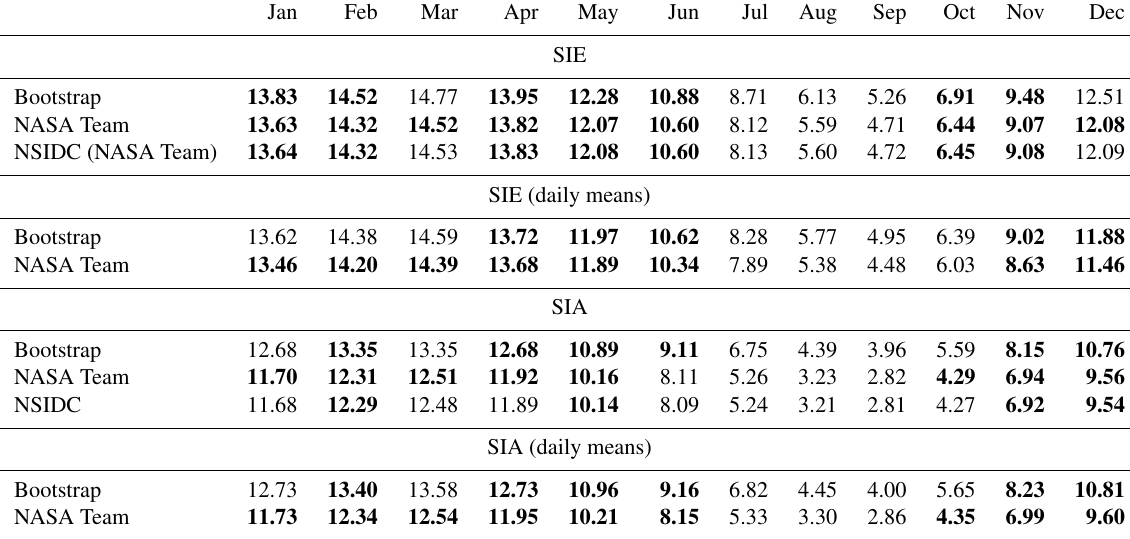
Table 1. Monthly 2016 Arctic sea ice extent (SIE) and sea ice area (SIA) calculated using the NASA Team and Bootstrap sea ice concentration data, along with the SIE / SIA given by the NSIDC Sea Ice Index (v2.1). The bottom rows (daily data) show the values calculated using monthly means of daily SIE / SIA values. Values in bold indicate a new record low.